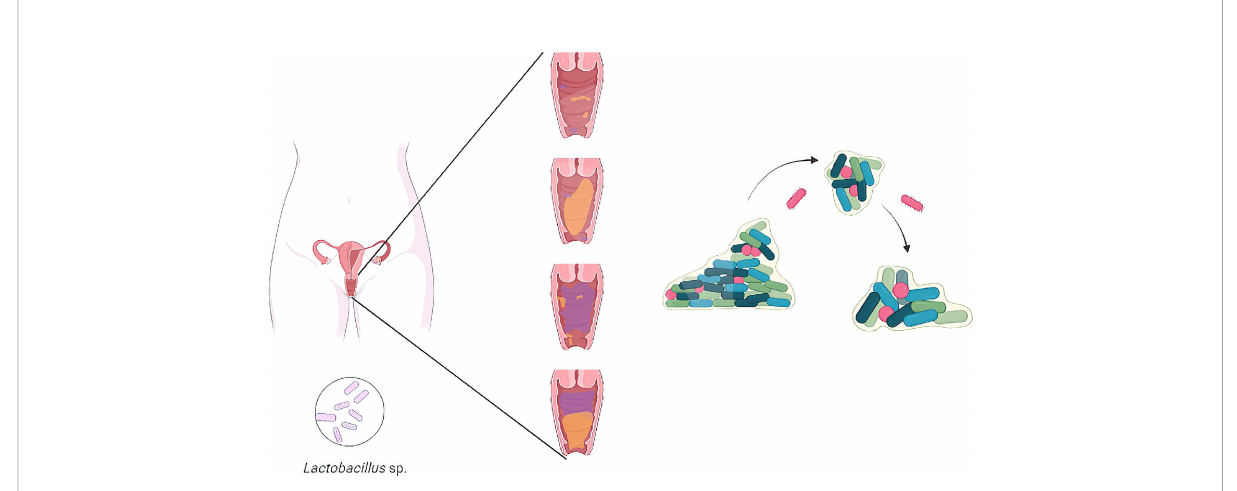
FIGURE 1 Representative illustration of the transition from a healthy vaginal microbiota with a high concentration of Lactobacillus species to the establishment of a vaginal dysbiosis in